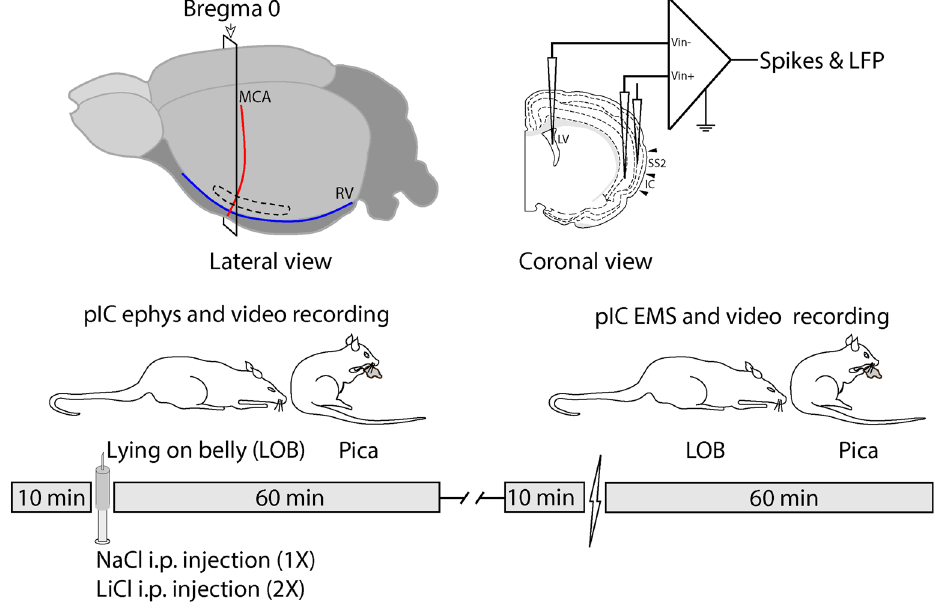
signs of GI malaise. To examine how specifically the neural activity in the pIC responds to GI malaise, we compared these results with those obtained using NaCl IP. To determine how specifically the pIC responds to GI